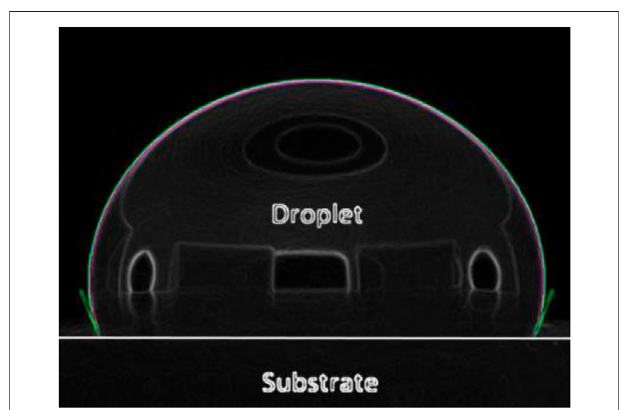
FIGURE 2 | Contour fi tting — green line — of liquid steel sessile